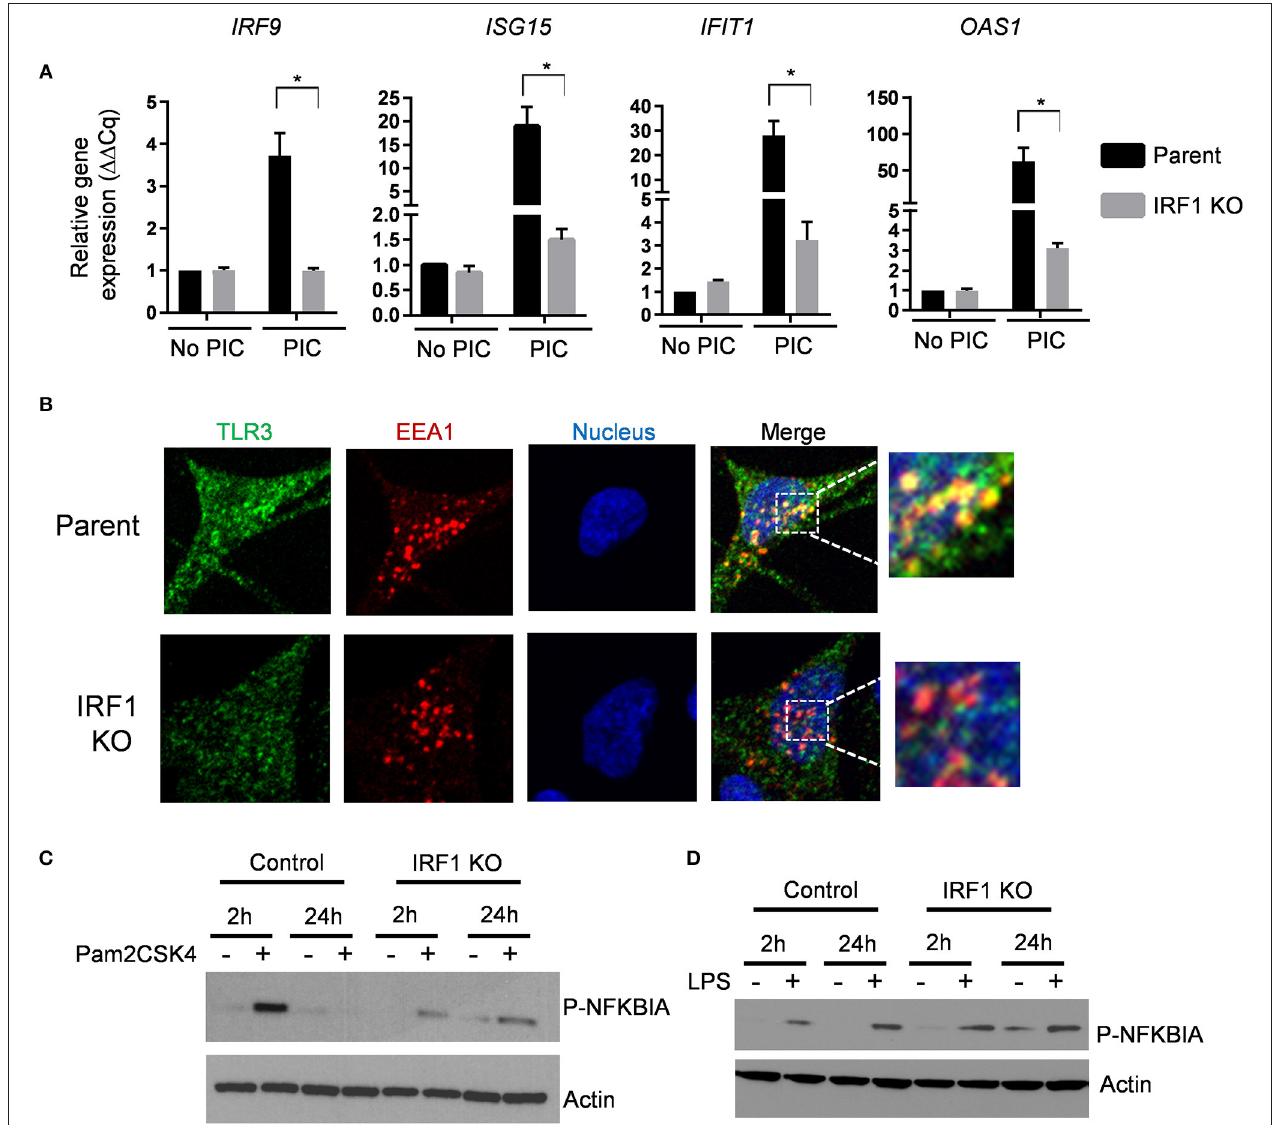
FIGURE 7 | IRF1 regulates TRL2 and TLR3 signaling. (A) Parent and IRF1 KO cells were treated with poly I:C (1 µ g/mL) for 6h and IRF1 independent ISG expression was examined by RT-qPCR comparative C q method (2 − 11 Cq ). Data represent mean ± SEM from three independent experiments. (B) Parent and IRF1 KO cells were processed for confocal microscopy to examine localization of TLR3. Antibody against EEA1 was used to examine localization of early endosomes. Images from individual channels for TLR3 (green), EEA1 (red), and nuclei (blue) are shown. Right panels show images with merged channels with magnified view as inset. (C,D) Parent and IRF1 KO cells were treated with the respective TLR2 and TLR4 agonists, Pam2CSK4 at 1ng/ml (C) , or LPS at 10 ng/ml (D) and activation of NF-kB pathway was examined by western blot with anti-phospho-NFKBIA (S32). *Statistically